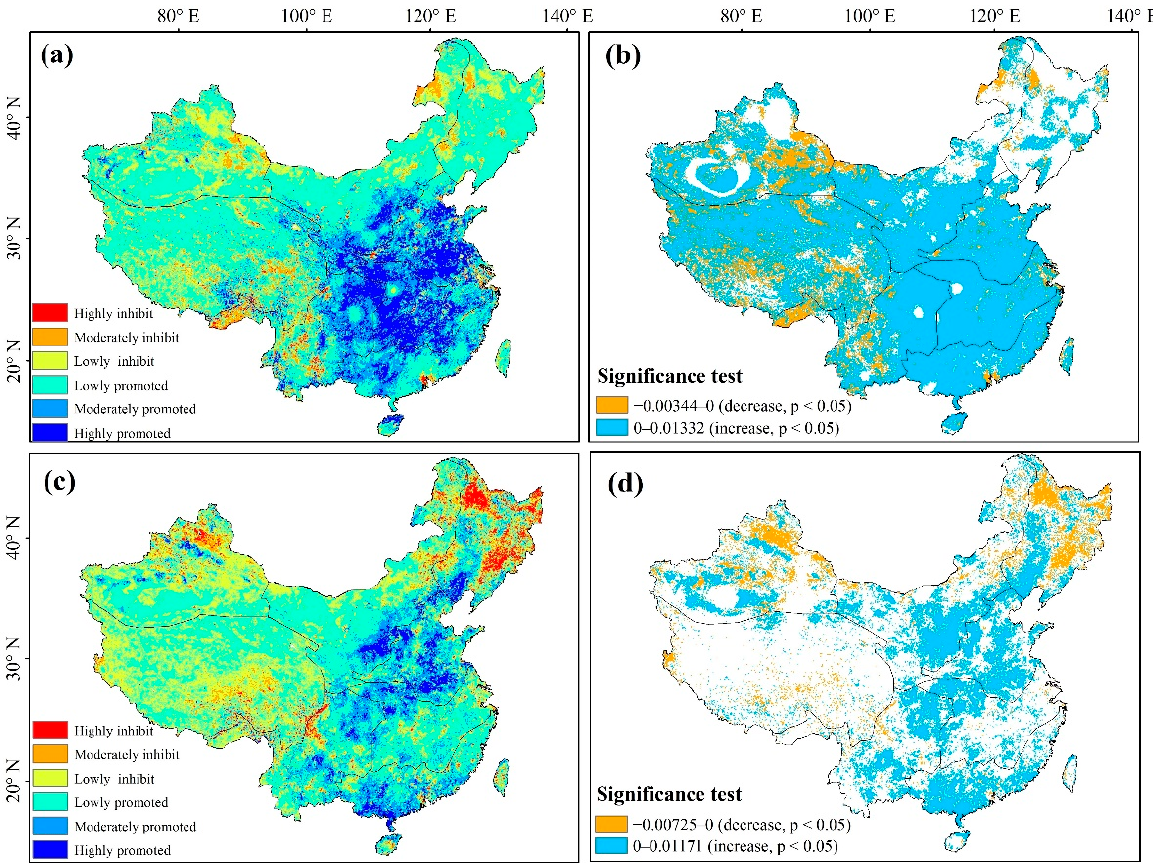
Figure 13. Sen trend analysis and M–K significance test of NDVI under the impacts of climate change ( a , b ) and human activities ( c , d